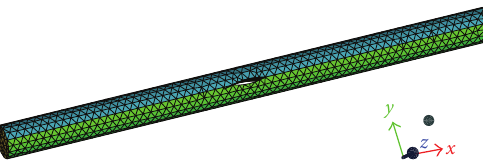
Figure 6: Blade in cylindrical channel.